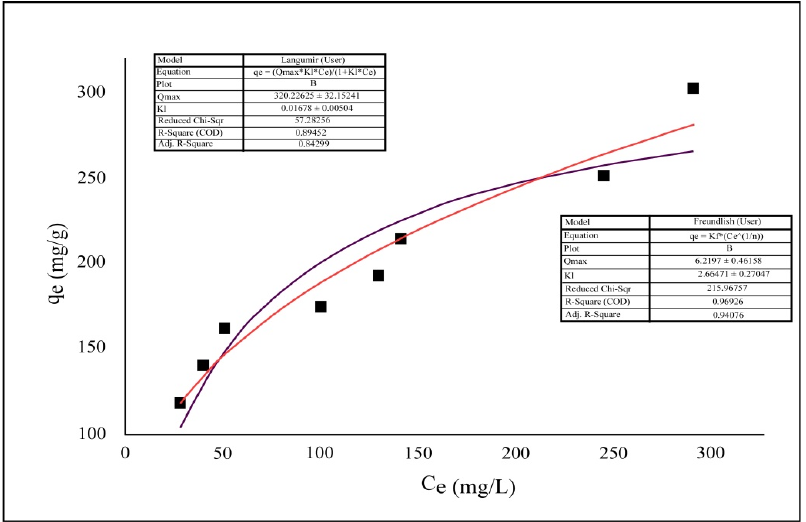
Figure 11. Non-linear adsorption isotherm models of Cr(VI) up taking upon TIHP fitted to experi- mental adsorption.